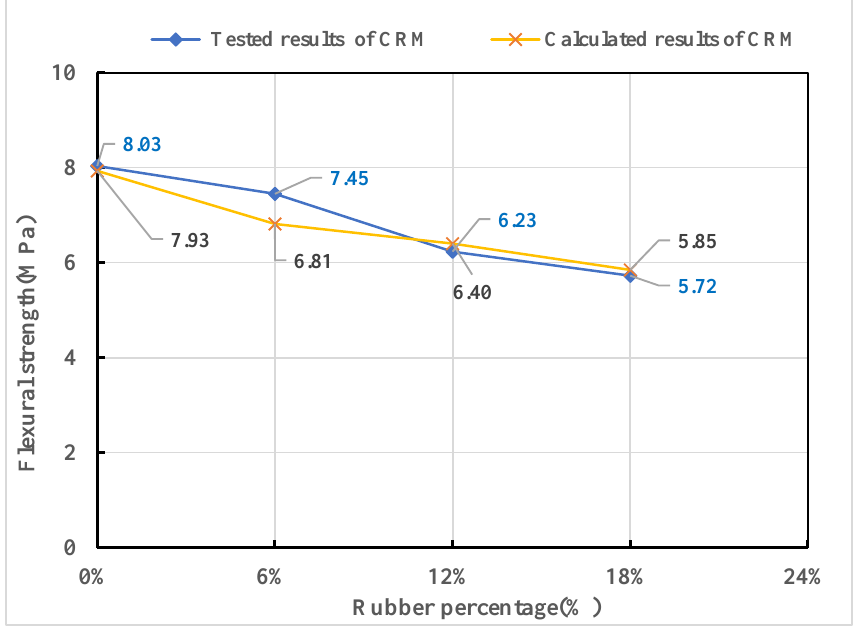
Figure 27. Comparison of experimental and calculated values of flexural strength of CRM.